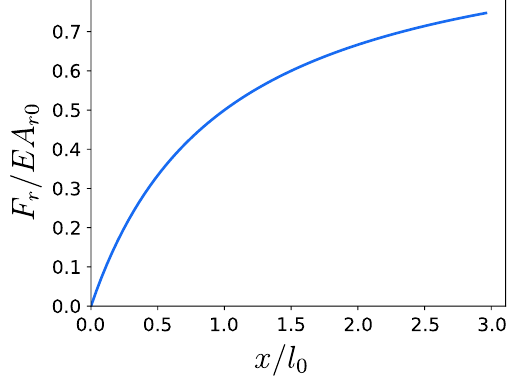
Figure 6. Relationship between x and F r